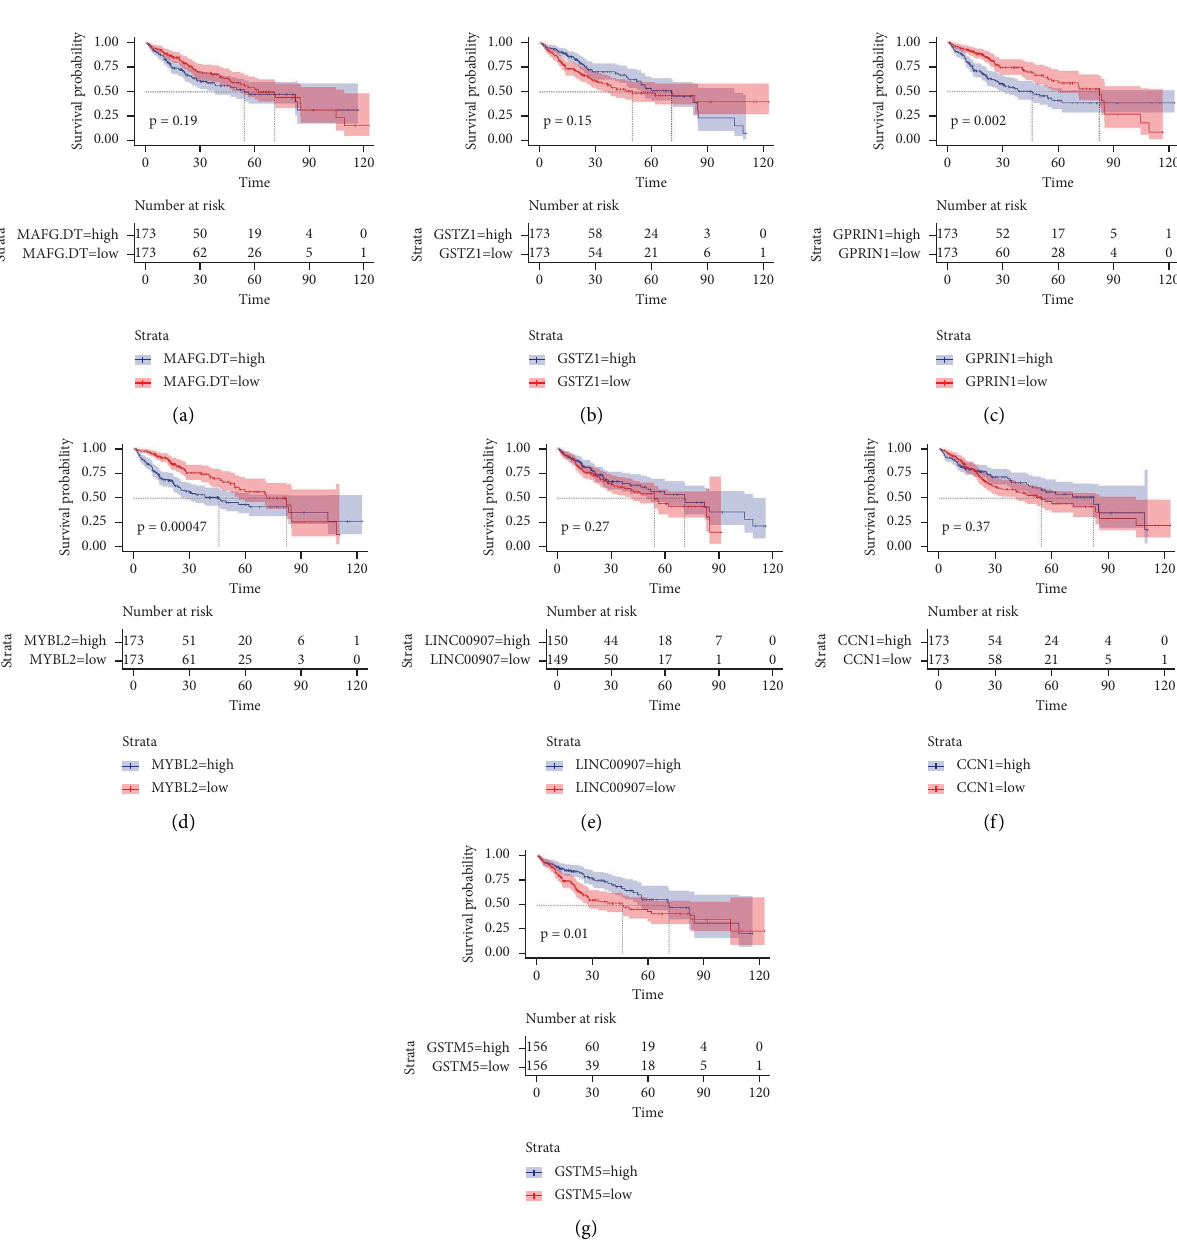
Figure 7: Survival curves of the relationship between common DEGs and prognosis of HCC patients: (a) MAFG-DT; (b) GSTZ1; (c) GPRIN1; (d) MYBL2; (e) LINC00907; (f) CCN1; (g)